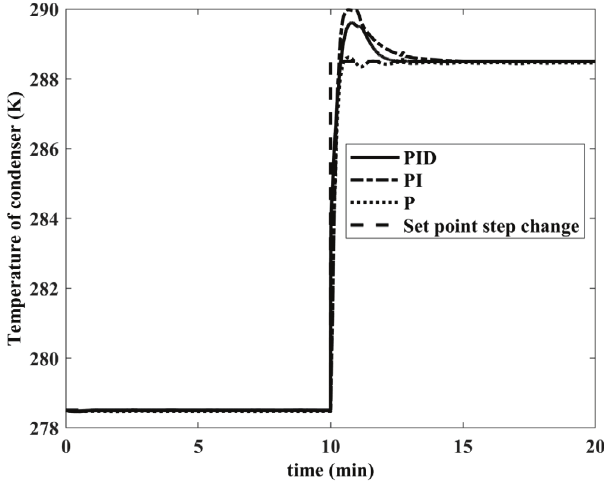
Fig. 8 – Performance of different controllers for tracking set- point step change in distillate temperature